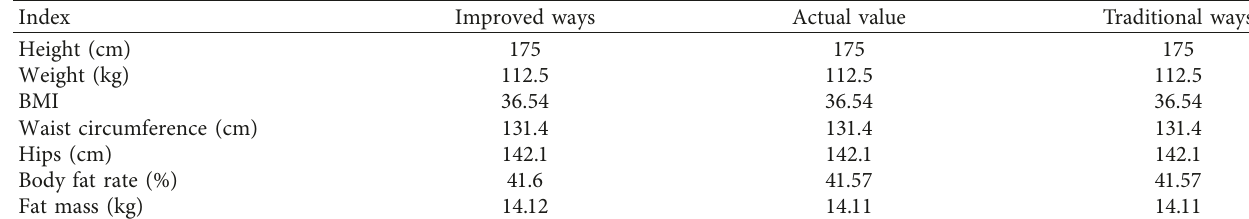
Table 1: Changes in index values before exercise by different methods.